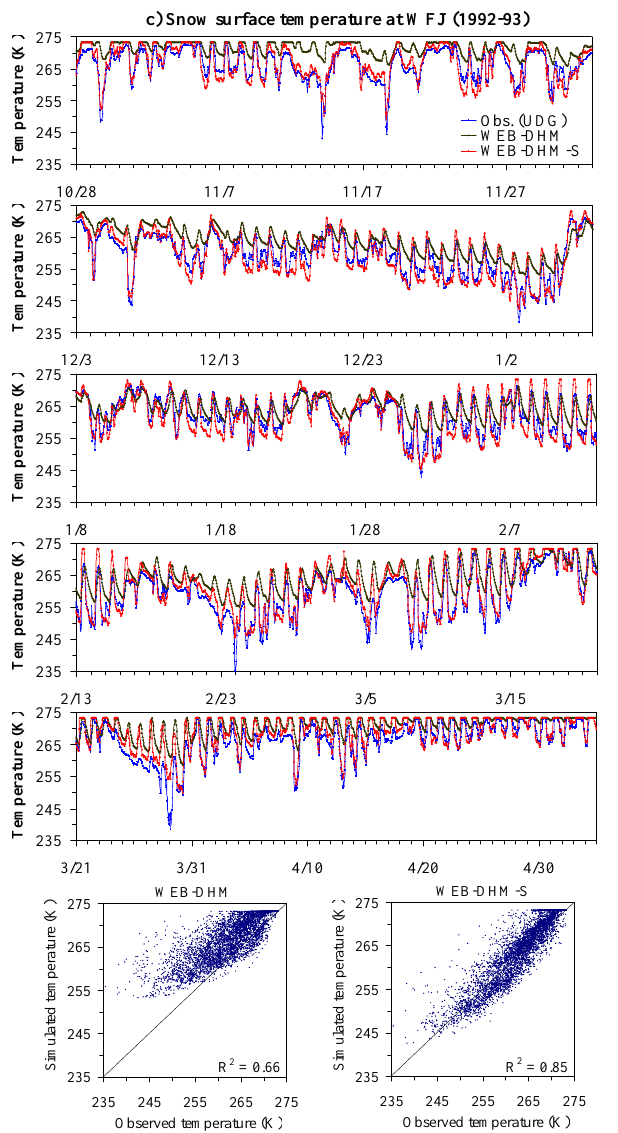
Fig. 6. Comparison of simulated daily totals of snowmelt runoff with the available observed values at (a) CDP (1996–1997), (b) CDP (1997–1998) and (c) WFJ